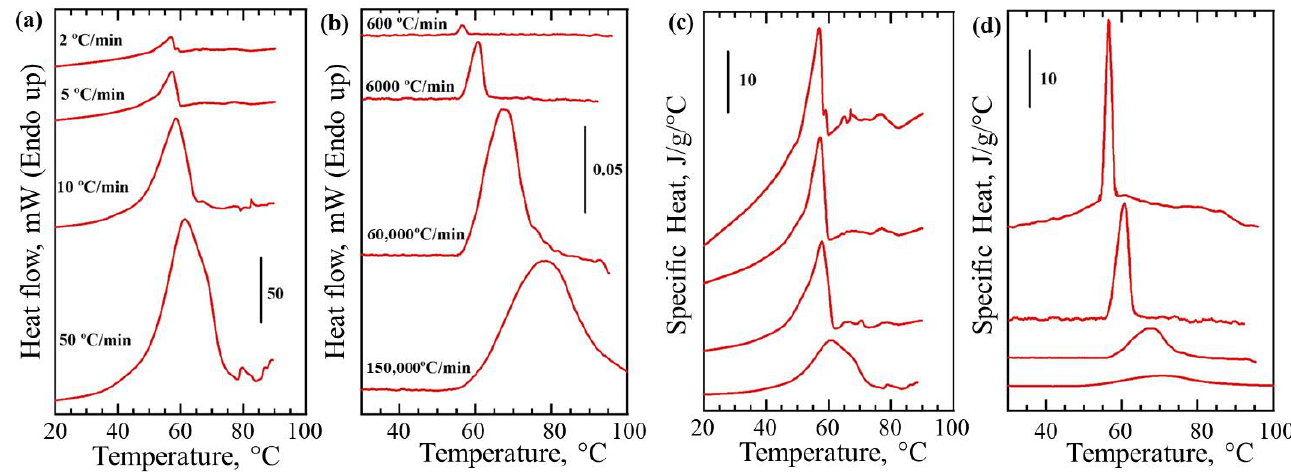
Figure 4. Thermal analysis of model polymer with the melting point closer to physiological temperature range using DSC and thermal nano-analyzer. Heat flow vs. sample temperature recorded with conventional DSC using 19 mg PEG ( a ) and thermal nano-analyzer instrument using 16 ng PEG particle deposited on the sensor ( b ). Heating rates used are shown next to relevant graphs. Artefacts on the DSC curves in the high temperature region are due to the sample leaking. PEG melting can be detected in a wide range of the scanning rates from 600 to 150,000 °C min − 1 . Specific Heat vs. sample temperature for DSC ( c ) and thermal nano-analyzer ( d ) were calculated by correcting for heating rate and sample weight.